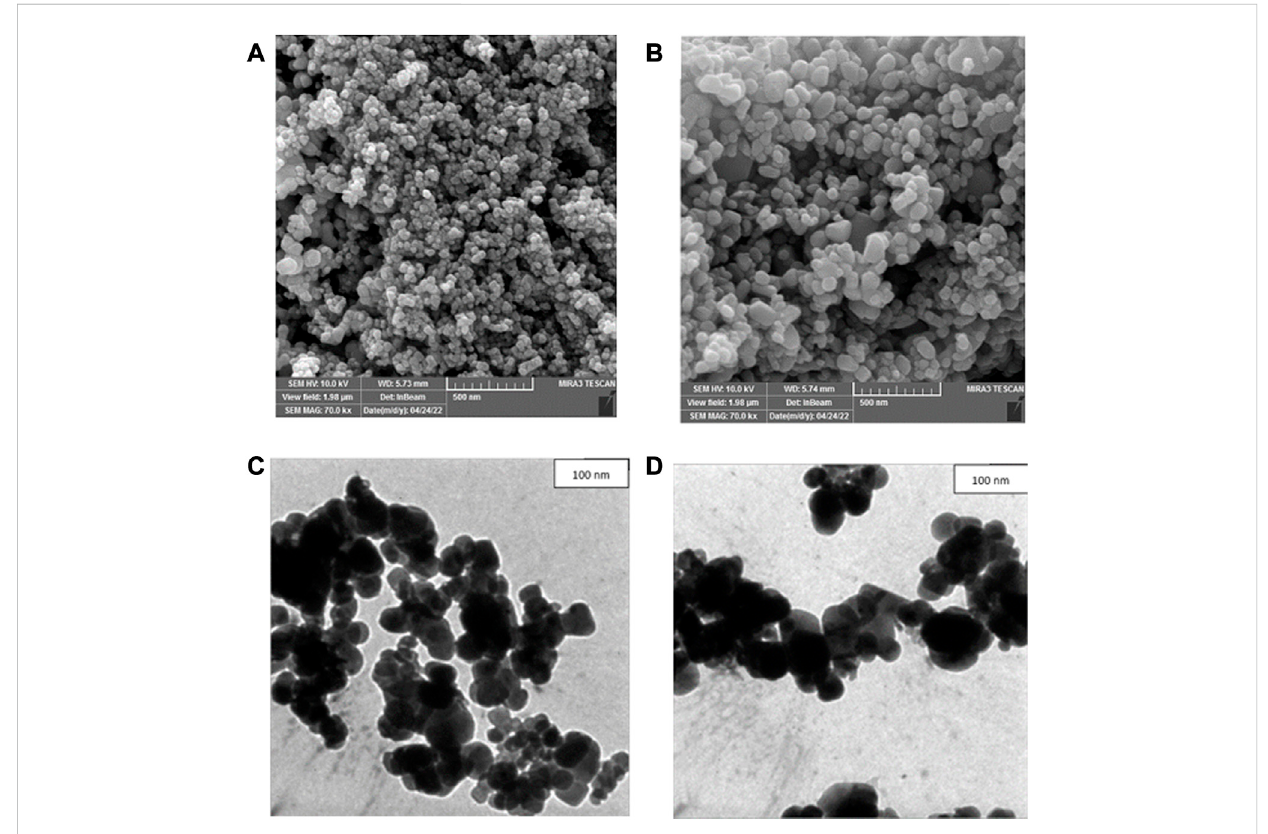
crude and calcined CuONPs when compared with untreated cells (Figure 9). Calculated IC 50 values of